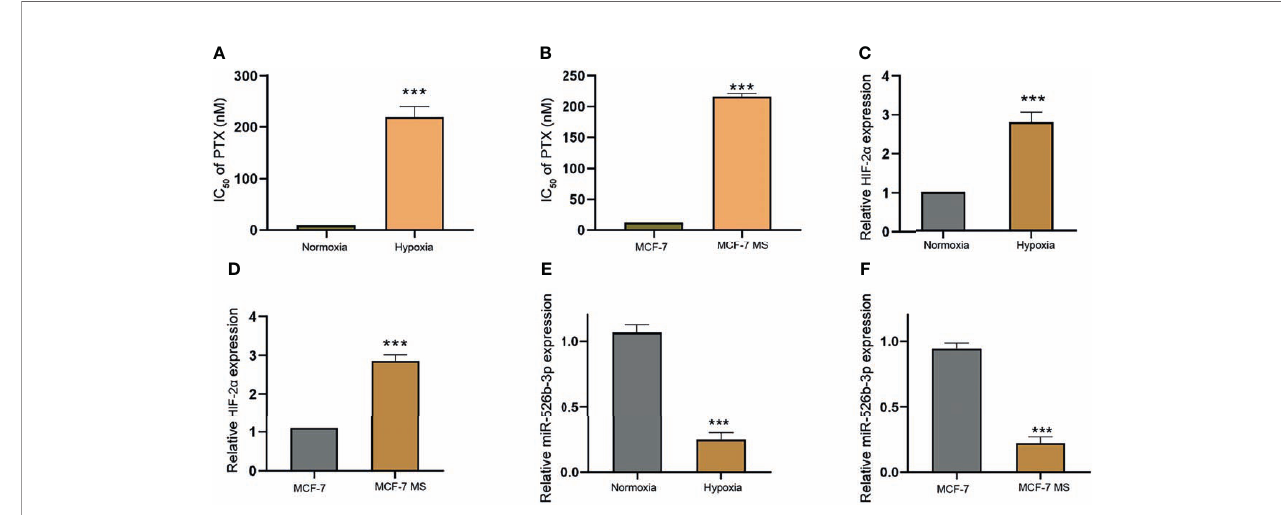
FIGURE 3 | Hypoxia enhances PTX resistance and HIF-2 a expression and reduces miR-526b-3p expression in breast cancer cells. (A) IC 50 value of PTX was compared in MCF-7 cells under hypoxia or normoxia condition. (B) IC 50 value of PTX was compared in MCF-7 cells and MCF-7 mammospheres (MCF-7 MS). (C) The expression of HIF-2 a was evaluated by qPCR in MCF-7 cells under hypoxia or normoxia condition. (D) The expression of HIF-2 a was assessed by qPCR in MCF-7 cells and MCF-7 MS. (E) The expression of miR-526b-3p was evaluated by qPCR in MCF-7 cells under hypoxia or normoxia condition. (F) The expression of miR-526b-3p was assessed by qPCR in MCF-7 cells and MCF-7 MS. Data are mean ± SD: *** p <